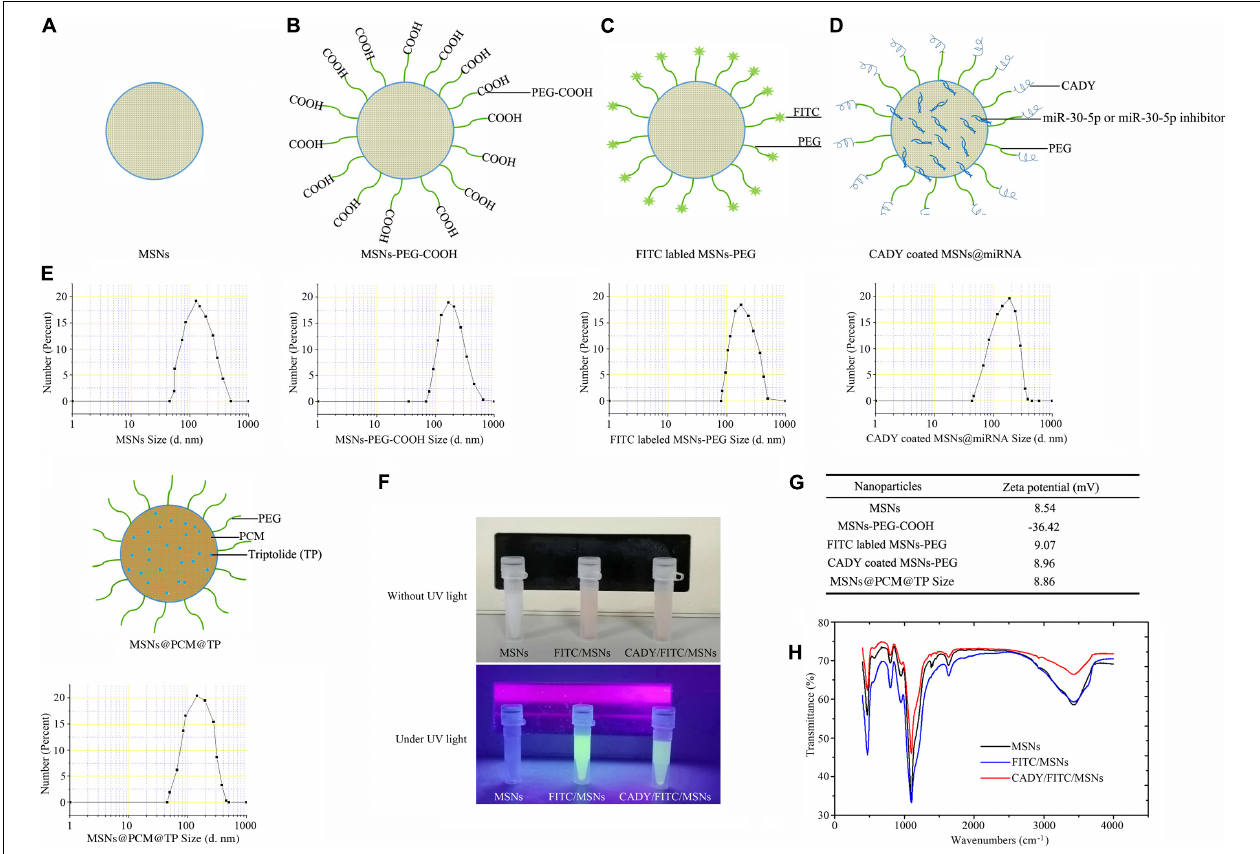
FIGURE 3 | Schematic of the procedures: DLS, zeta potential and FT-IR spectra of different nanoparticles. (A–E) Patterns of and DLS results of MSNs, MSNs-PEG-COOH, FITC-labeled MSNs-PEG, CADY-coated MSNs@miRNA, and MSNs@PCM@TP. (F) FITC-labeled MSNs and CADY-coated FITC-labeled MSNs were irradiated by an ultraviolet lamp. (G) Zeta potential of the MSNs, MSNs-PEG-COOH, FITC-labeled MSNs-PEG, CADY coated MSNs and TP-loaded MSNs-PEG. (H) FT-IR spectra of MSNs, FITC-labeled MSNs and CADY-coated FITC- labeled